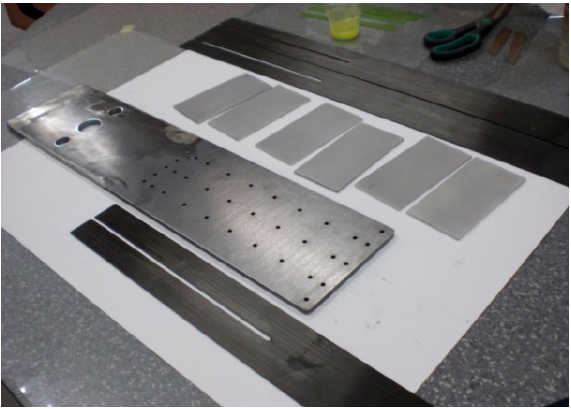
Figure 7. One-sided N-type anchorage of the NPS II system tested in the S3N-S5N series.